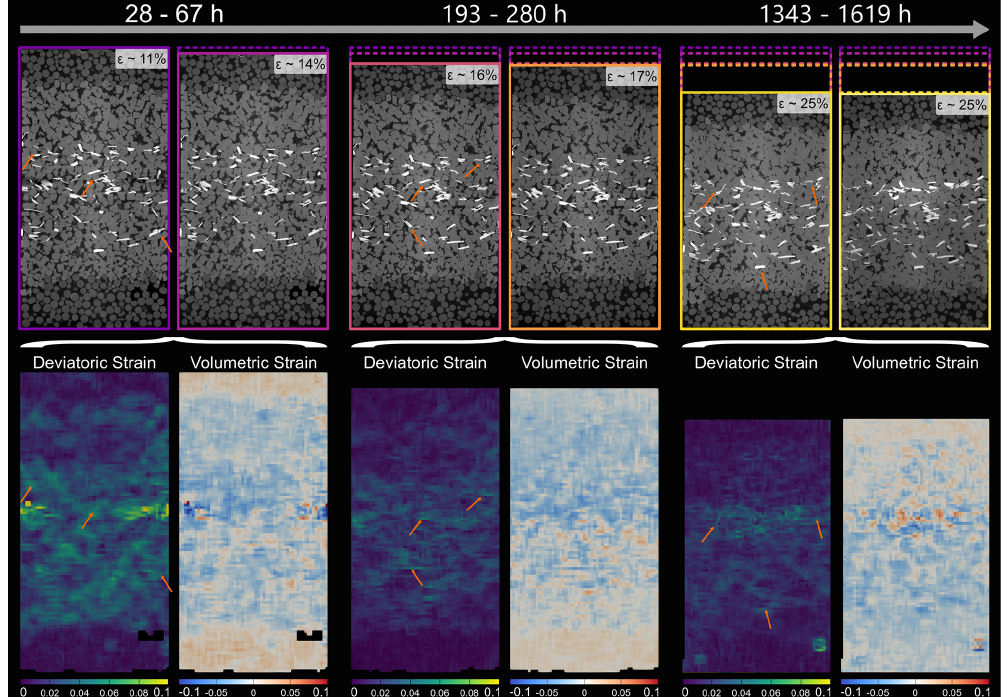
Figure 9. Locally resolved strain in the SBS sample. The absolute values of deviatoric and volumetric strain were calculated from digital volume correlation for three different time steps. The top row shows the two microtomography scans which were compared to each other using digital volume correlation. Further, the contours are showing the sample dimensions, ranging in colour from purple for the least compacted sample to light yellow for the most compacted sample. In the bottom row, the results of the strain calculation are displayed. Note that the strains are cumulative and cover the entire time interval between the two selected scans. The durations of the time intervals increase from the left to the right and are 39, 87 and 276h. For the deviatoric strain, bright colours represent high strains, whereas dark colours represent low strains. For the volumetric strain, blue indicates compaction, while red indicates dilatation. Note that the strains are resolved on the grain scale. Arrows point to high deviatoric strains at NaCl–biotite interphase boundaries.